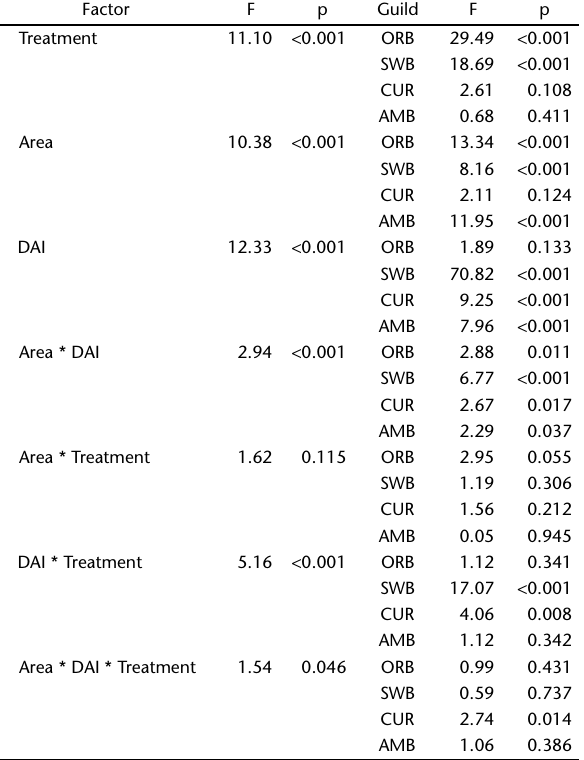
Table III. Multivariate GLM results and tests for between-subject effects for spider guild abundance considering three factors: treatment (with and without insecticide), areas (three sites in Rio Grande do Sul, Brazil) and time in days after insecticide application(DAI), and their interactions. Years are included as blocks (not shown). See text for